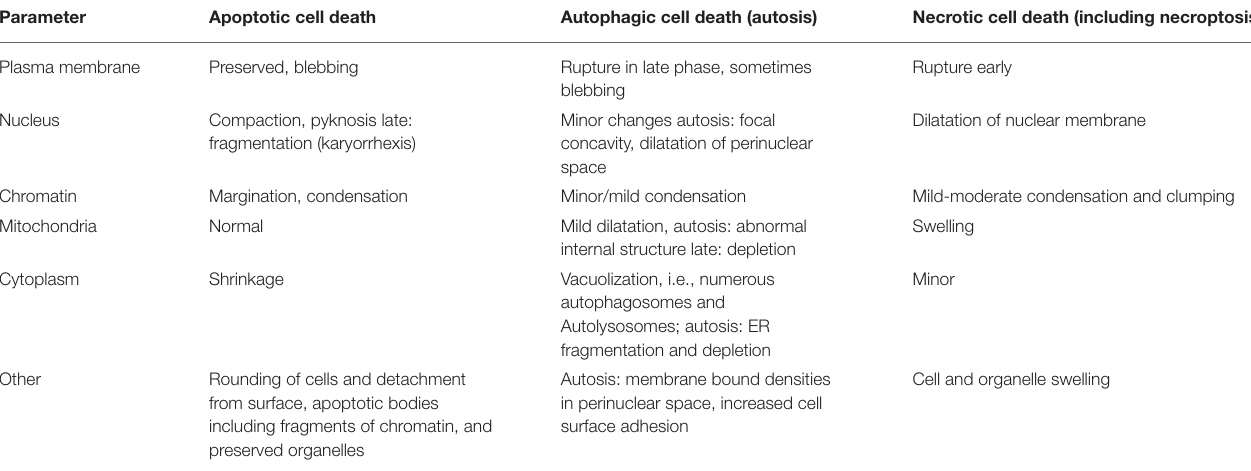
TABLE 1 | Comparison between morphological features of type I, type II, and type III cell